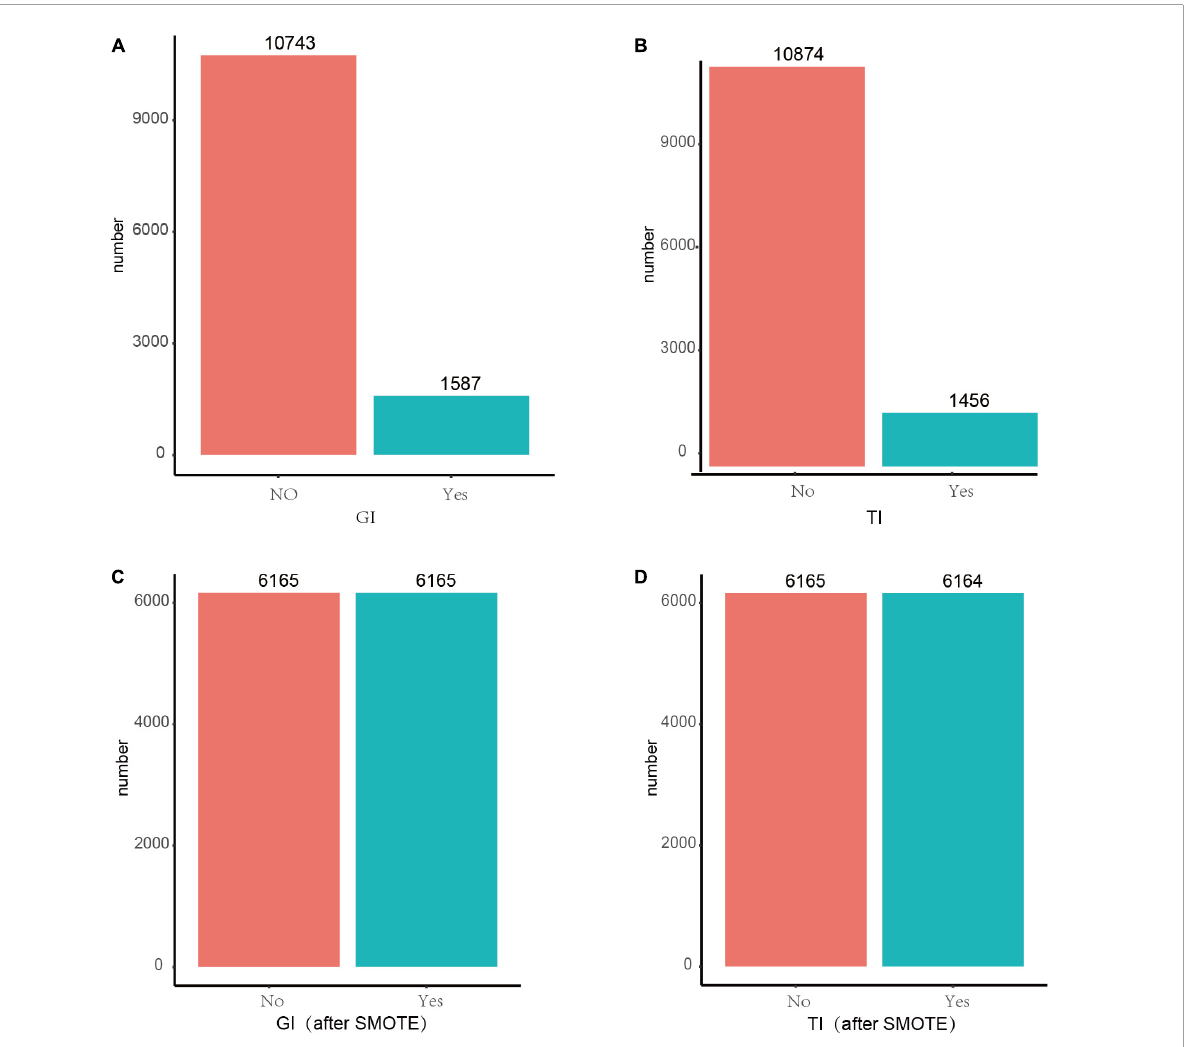
FIGURE1 Before and after SMOTE of response variables for GI and TI. SMOTE, Synthetic Minority Over-Sampling Technique. It’s a good and powerful way to handle imbalanced data, and it was conducted under the parameters of k = 5, C.perc = “balance,” dist = “Overlap.” (A) GI before SMOTE; (B) TI before SMOTE; (C) GI after SMOTE; (D) TI after